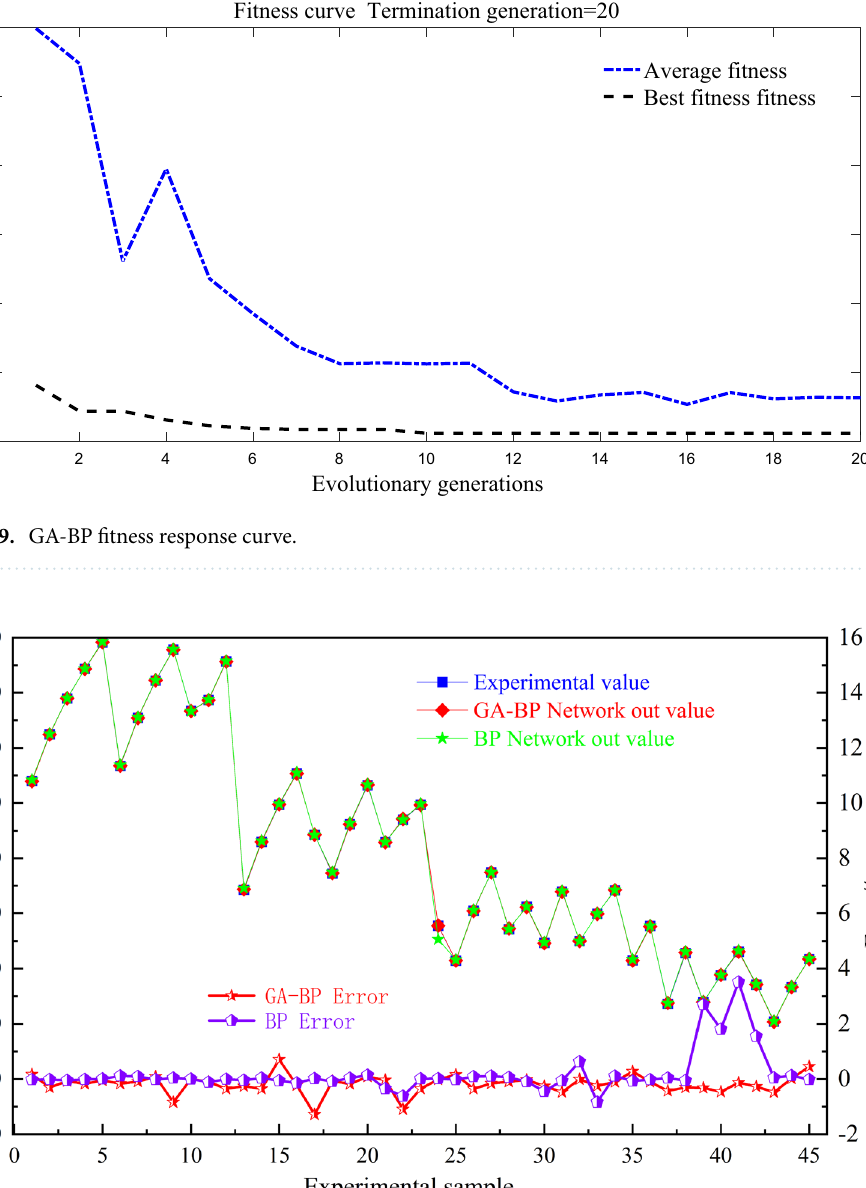
Figure 10. Model training